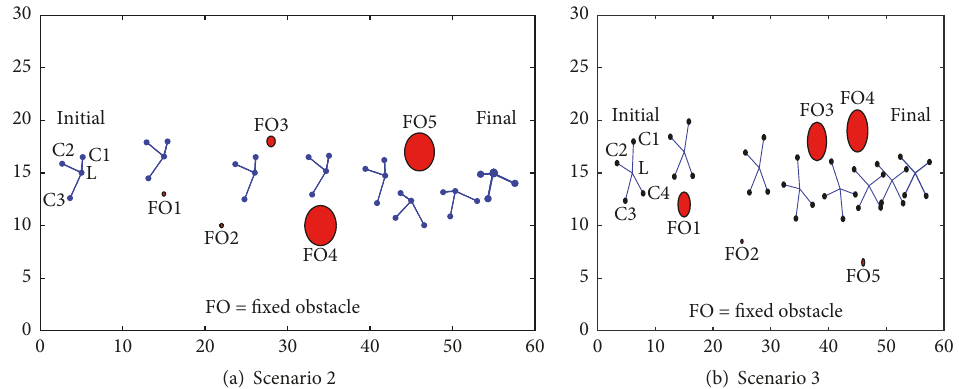
Figure 7: Scenarios 2 and 3. Evolution of trajectories for different lead-carrier teams. (a) and (b) have 3 (C1–C3) and 4 (C1–C4) carriers attached to the lead robot,